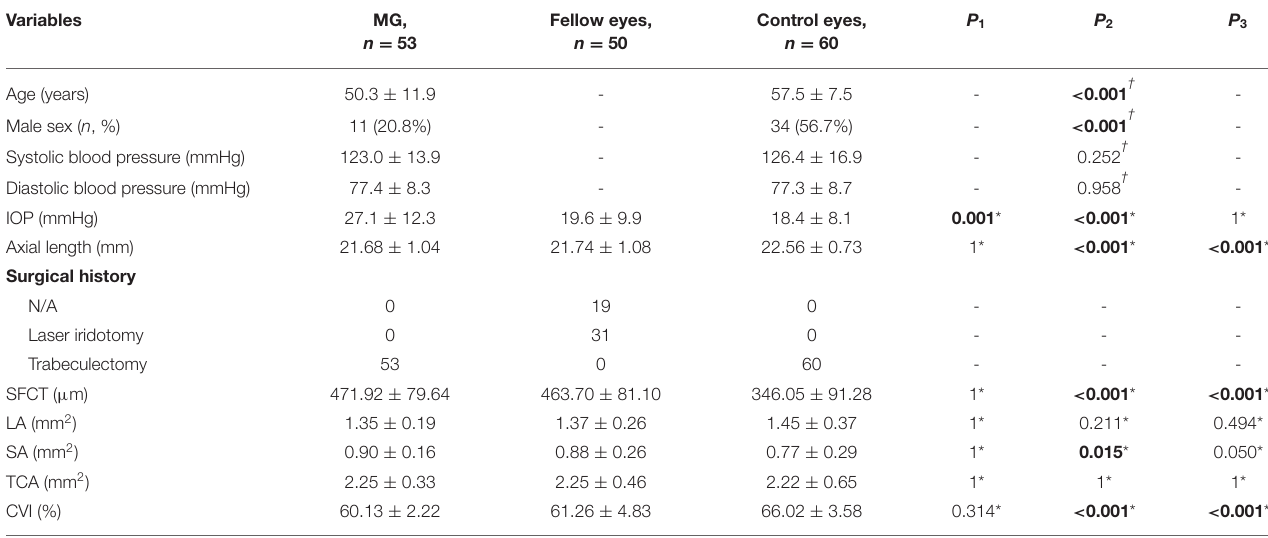
TABLE 1 | Demographic, clinical, and choroidal characteristics of eyes with MG with their fellow eyes and control eyes. Variables MG,